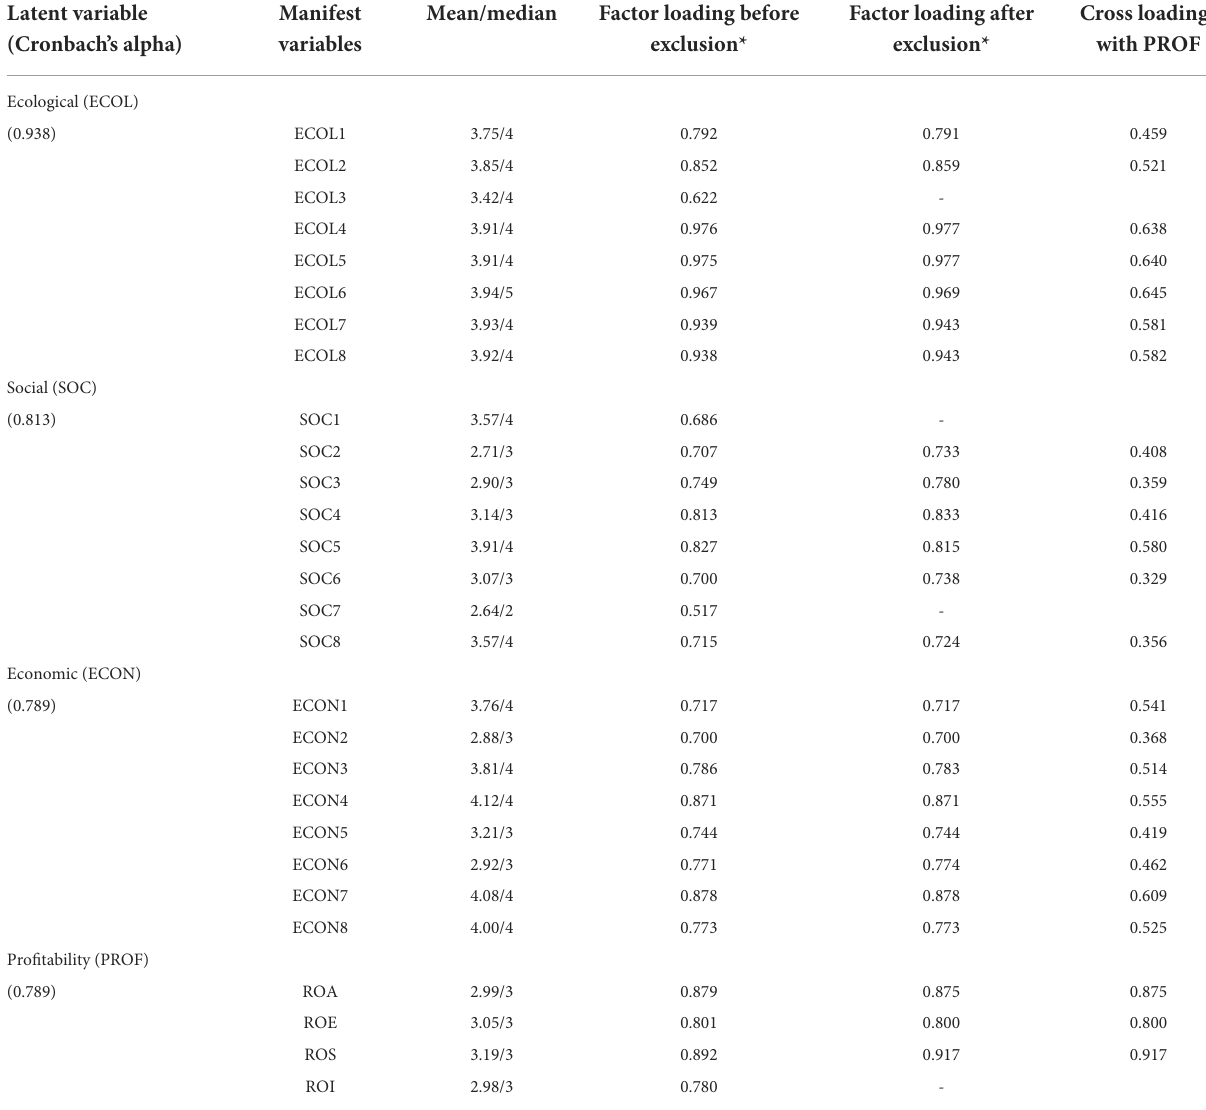
TABLE 3 Descriptive statistics, loadings, and composite reliability of the